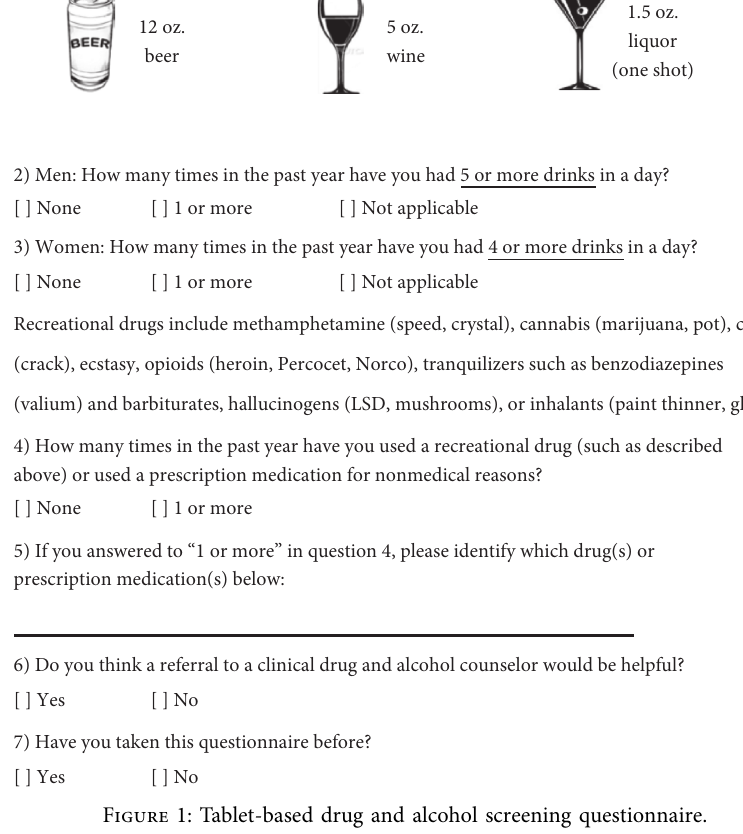
Figure 1: Tablet-based drug and alcohol screening